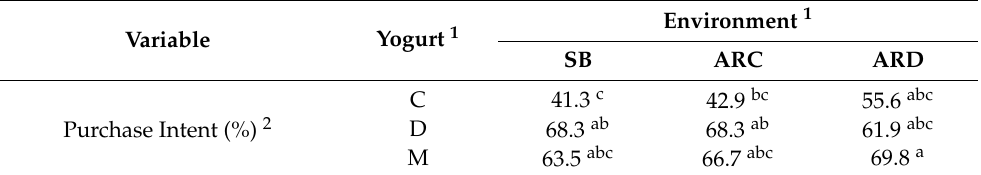
Table 3. The purchase-intent frequencies of yogurt samples under three contextual environments.